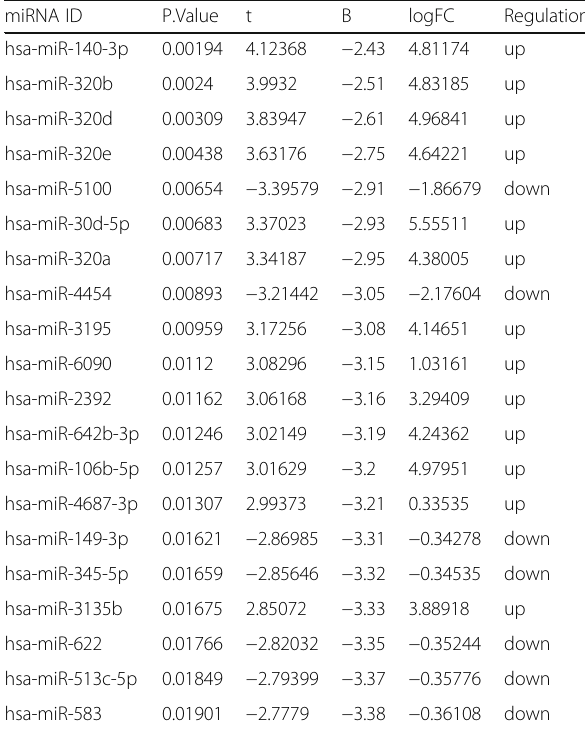
Table 3 DE-miRNAs miRNA